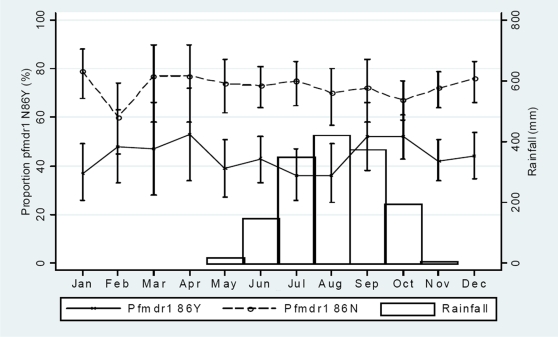
Monthly variation of pfmdr1 86N and 86Y haplotypes amongst children presenting with uncomplicated P. falciparum malaria between October 2002 and December 2007.Binomial exact 95% confidence intervals are presented as range spikes with caps.